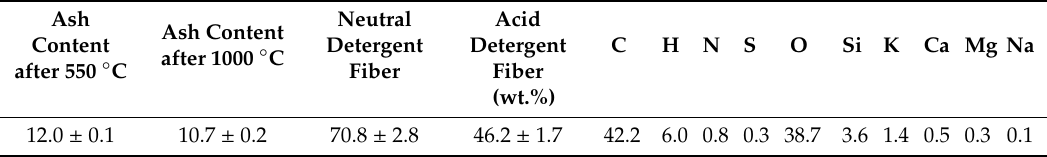
Table 1. Composition of the rice straw based on dry matter. (If standard deviation is indicated, four repetitions were performed.)